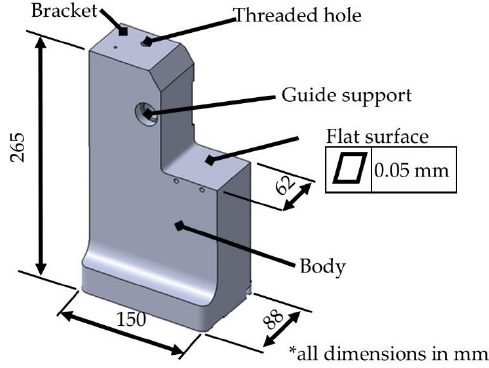
Figure 2. Location of the fixturing turrets for the anchoring of aeronautical parts.